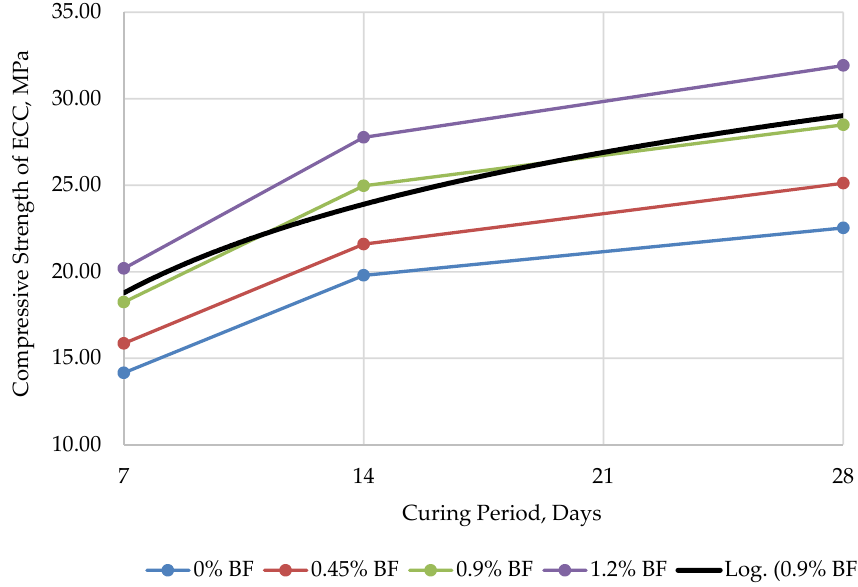
Figure 4. Compressive strength of control ECC specimens depending on the curing period (the fitting curve is shown as a black line).